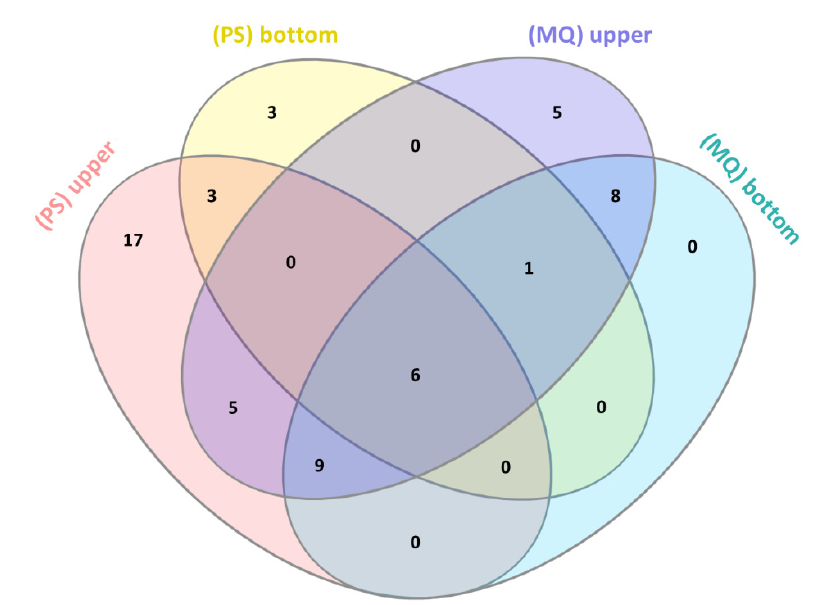
Figure 3. The comparison of the number of proteins identified in the upper and the bottom fractions using PeptideShaker (PS) and MaxQuant (MQ) software. In overall, PeptideShaker identified 40 proteins in the upper and 13 proteins in the bottom fraction, while MaxQuant reported 34 hits for the upper and 24 hits for the bottom fraction. Table 2. Protein families detected in fractions of Naja ashei venom using PeptideShaker (PS) or MaxQuant (MQ) software. The values in brackets represent the percentage share of a given group in a certain fraction but they are only included if the amount of certain family was not below one-thousandth of a percent. All values are available in Table